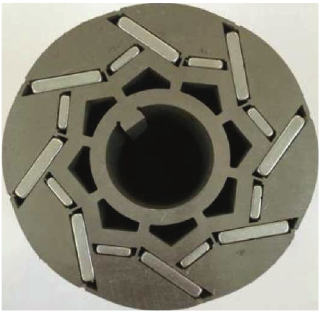
Figure 12: Rotor structure.